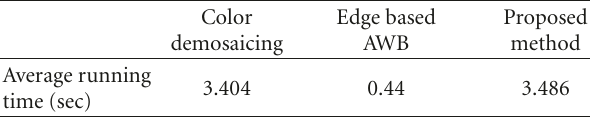
Table 4: The computational complexity